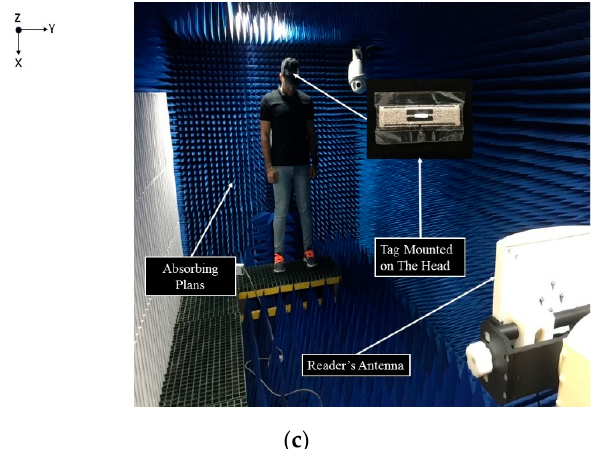
Figure 11. Reading distance of antenna when located on ( a ) chest, ( b ) arm, and ( c ) head as measured in the +z direction.